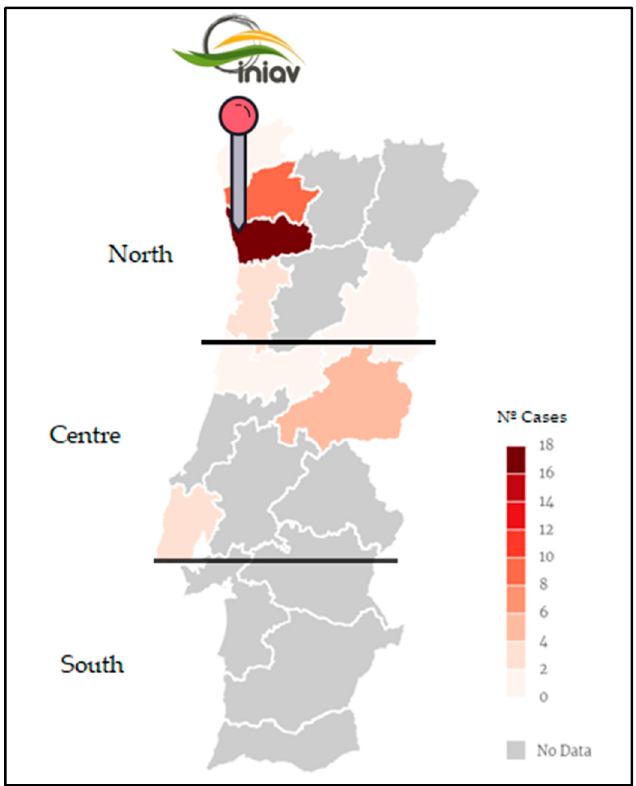
Figure 7. Geographical representation of the location of INIAV reference laboratory and the origin of the forensic cases included in this